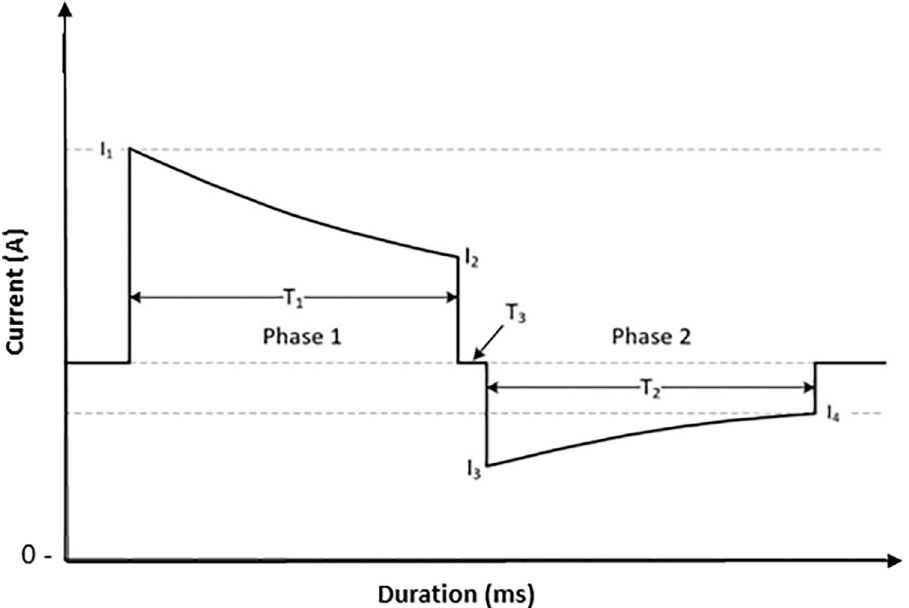
Fig 2. Typical Biphasic Truncated Exponential (BTE) shock waveform. Graphical r epresentation of the typical BTE waveform showing current as a function of time. I1 = Peak current, I2 = Phase 1 trailing edge current, I3 = Phase 2 peak current, I4 = Phase 2 trailing edge current, T1 = Phase 1 period, T2 = Phase 2 period, T3 = Interphase delay.